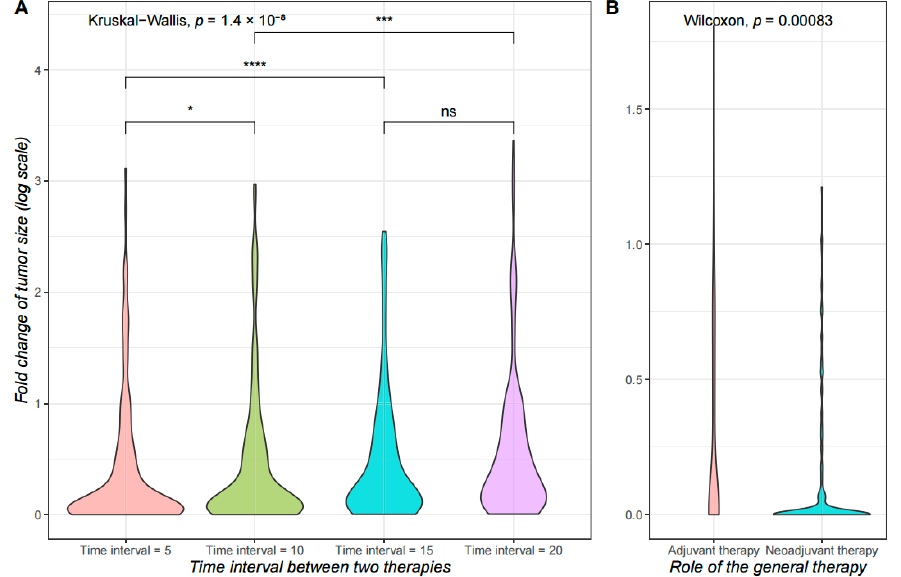
Figure 4. Treatment outcomes of different timings. The tumor size change across simulations is shown as violin plots. The y axis indicates the log-scaled fold-change of tumor size after 50 iterations of simulations. For all simulations, the first therapy is performed at time 100, and the fold-change is calculated between tumor sizes at time 100 and time 170. Simulations for each condition is repeated 200 times. Significance levels of difference among groups are shown (*: p -value ≤ 0.05; ***: p -value ≤ 0.001; ****: p -value ≤ 0.0001; ns: p -value > 0.05). ( A ) The x axis indicates whether the general therapy functioned as adjuvant therapy to the surgery (after surgery), or as a neoadjuvant therapy (before surgery); ( B ) The x axis indicates different time gaps between the first therapy and the adjuvant therapy.